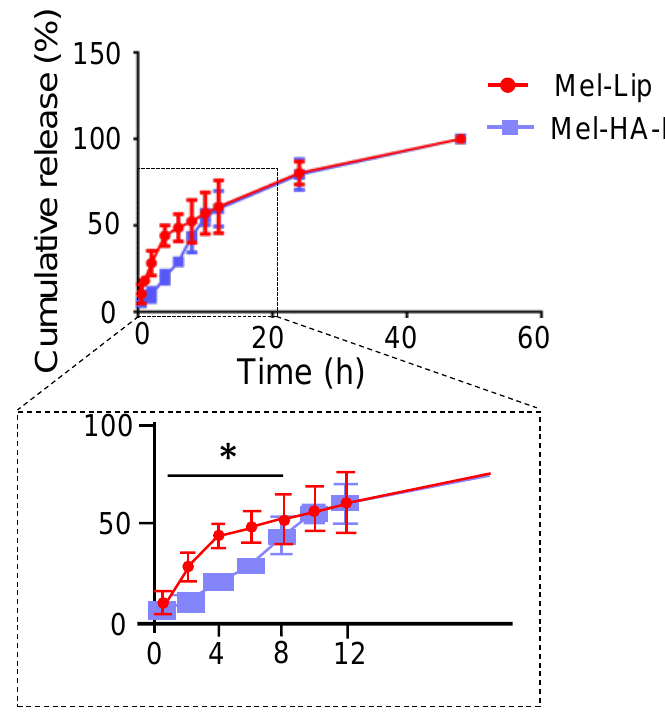
Figure 6. In vitro release profiles of melittin released from Mel-Lip and Mel-HA-Lip. (Mel-Lip compared with Mel-HA-Lip, * p < 0.05; n = 3).